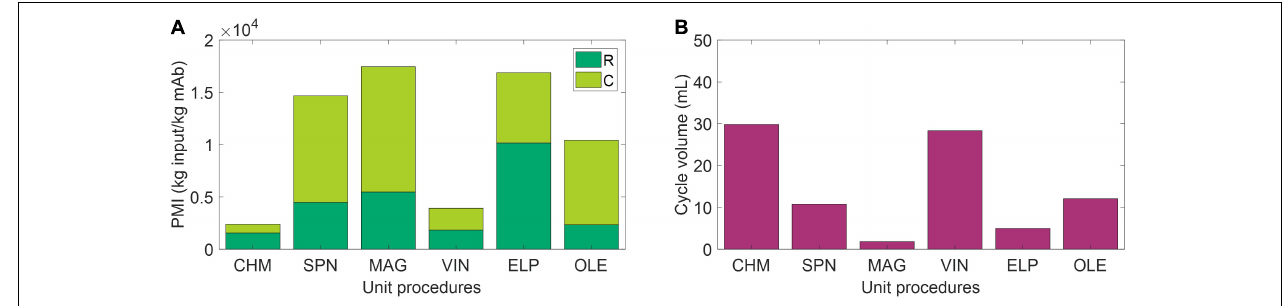
FIGURE 5 | (A) Process mass intensity (PMI) evaluation of the unit procedures broken down by raw materials (R) and consumables (C) contributions. (B) Cycle volume for each unit procedure. CHM, pre-packed chromatography; SPN, spin column; MAG, magnetic bead; VIN, plant virus-based nanoparticle; ELP, elastin-like polypeptide; OLE,